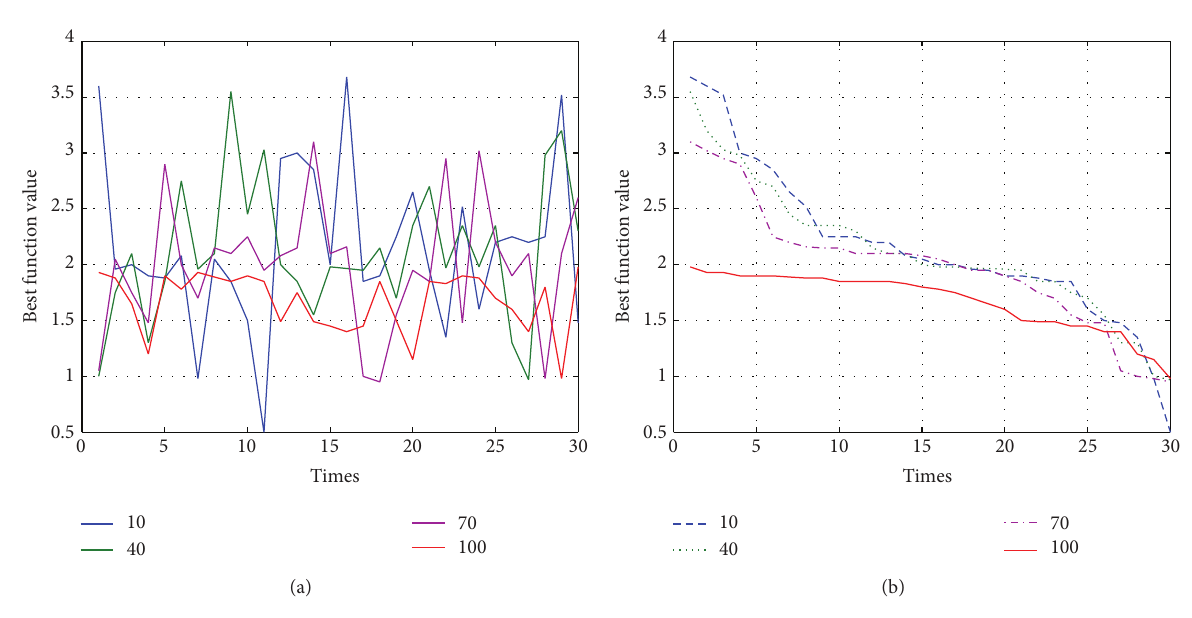
Figure 4: Optimization results on different values 𝑛 .